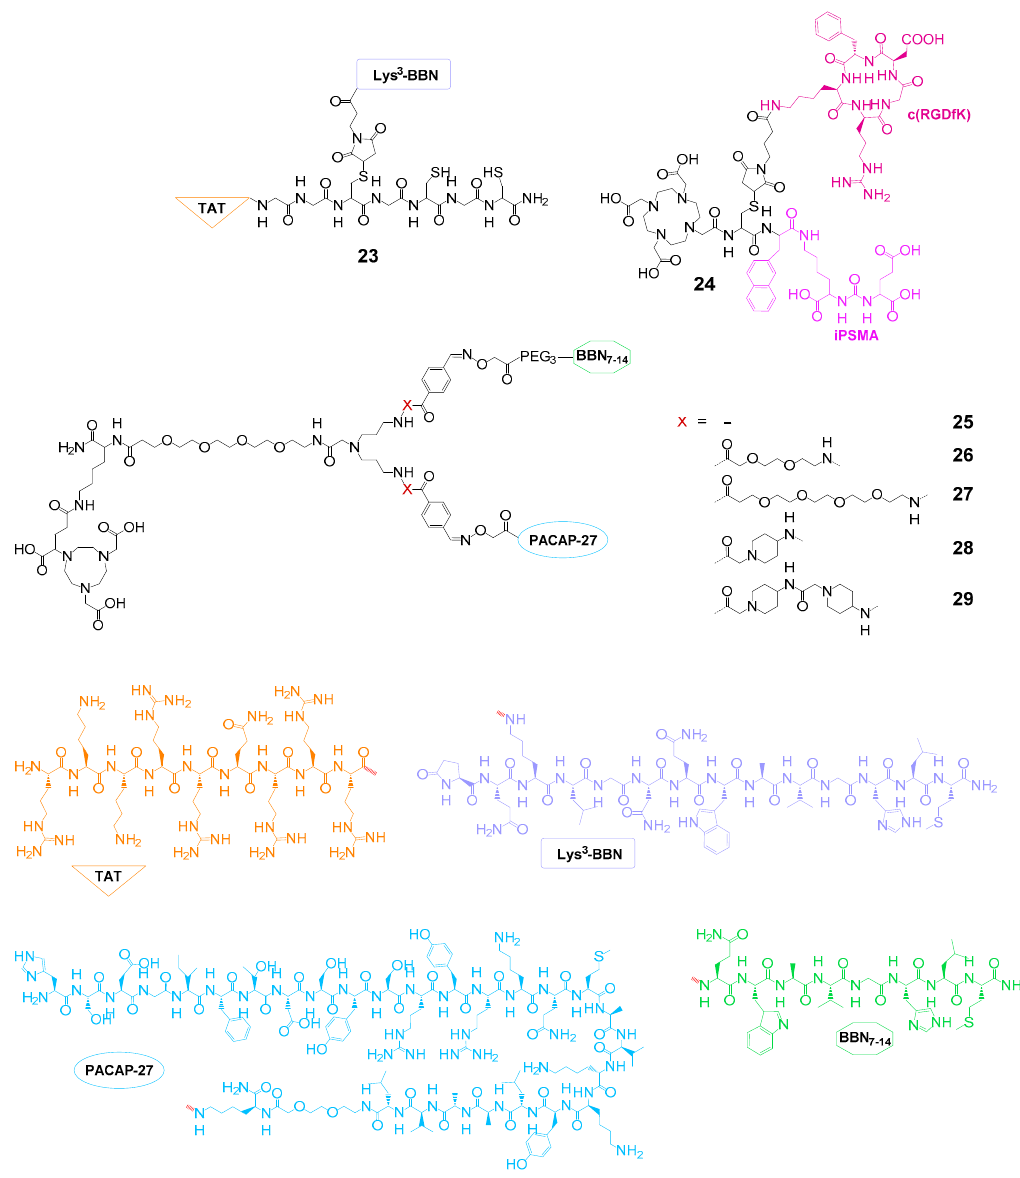
Figure 8. Structures of heterobivalent peptidic agents developed for PCa imaging or therapy, targeting different receptor systems.